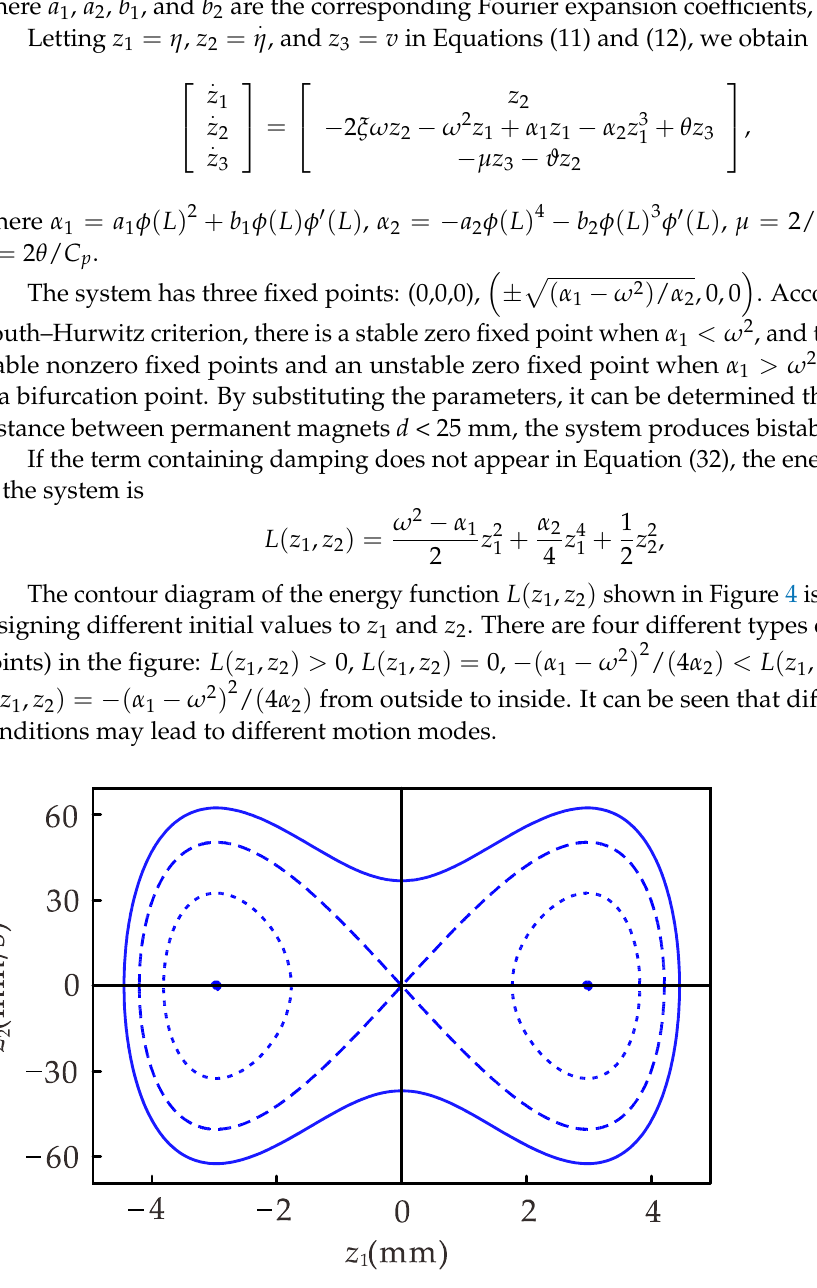
Figure 4. Contour diagram of the energy function.